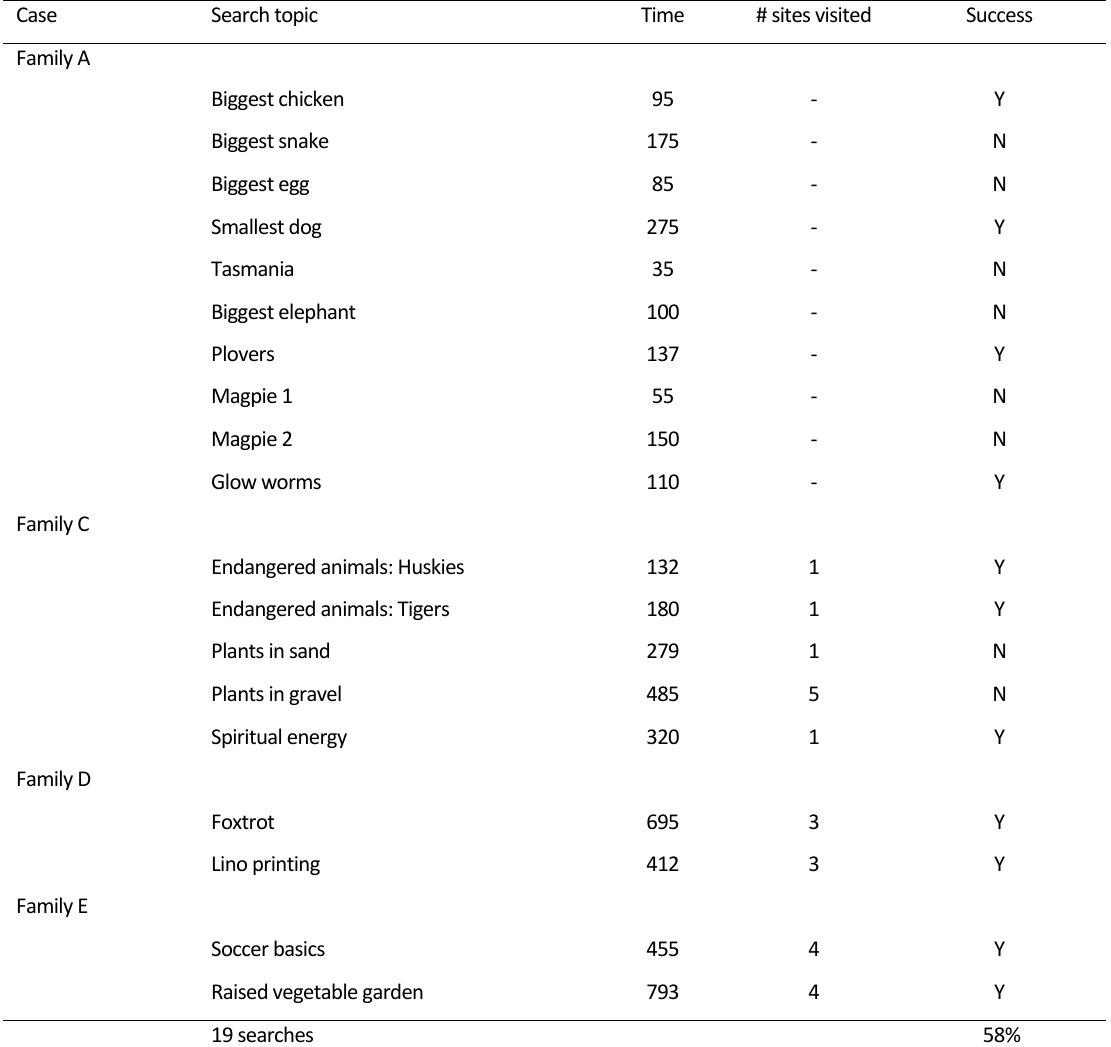
Table 2. Collaborative Online Search During